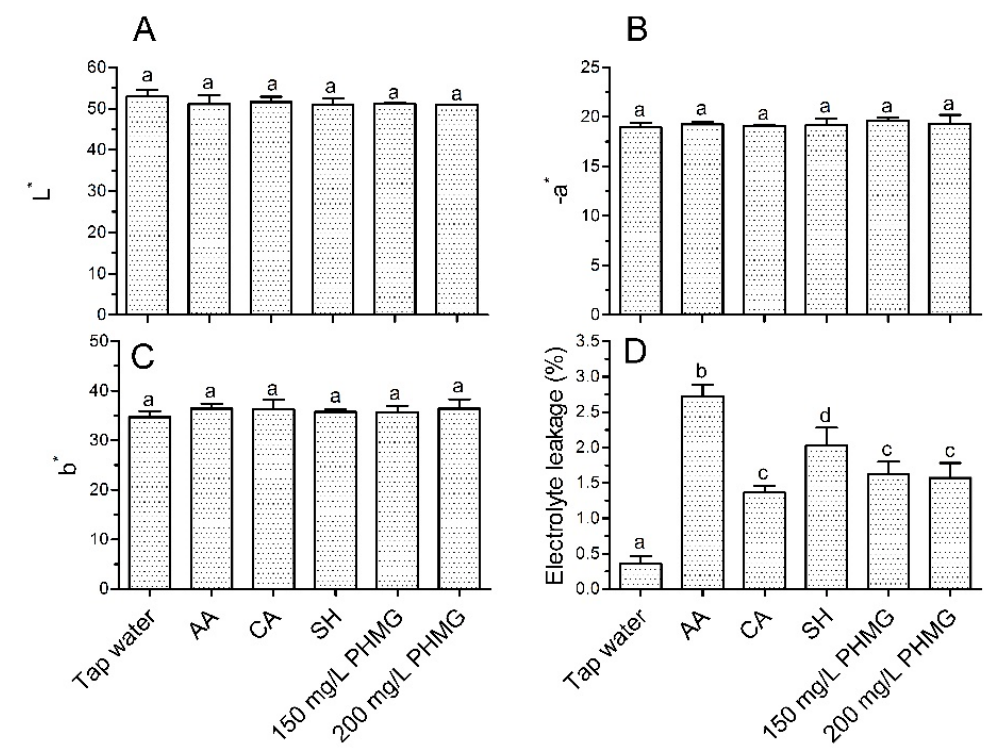
Figure 2. Effects of various treatments on instrumental color ( A – C ) and electrolyte leakage ( D ) of ready-to-eat lettuce. Bars show means and standard deviations, and different letters above the columns indicate significant differences ( p < 0.05). AA: acetic acid; CA: citric acid; SH: sodium